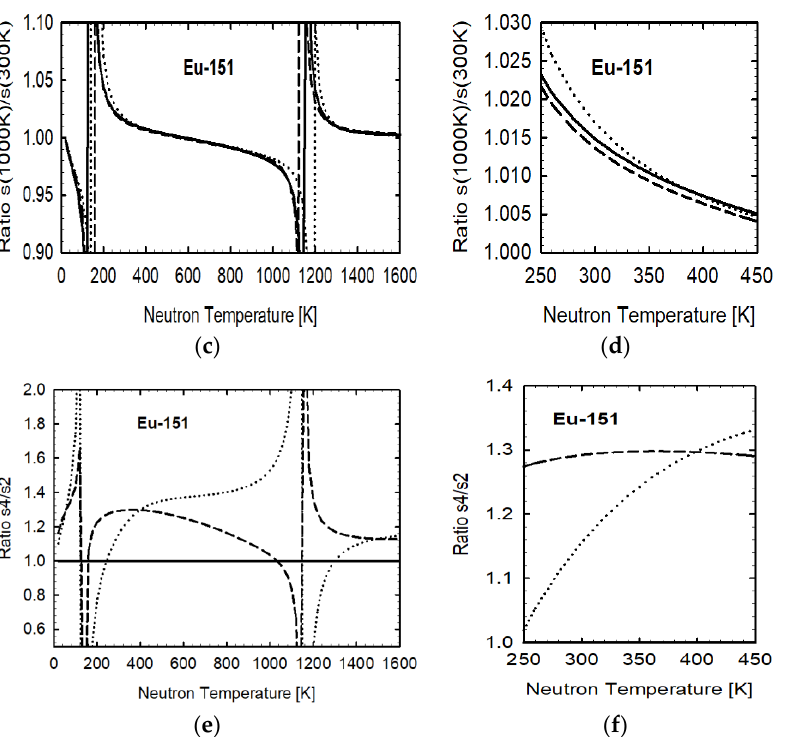
Figure 7. ( a ) s-factors, s 2𝑊 (solid line), s 4𝑊 (dotted line), s 4𝐻 (dashed line) for 151 Eu as a function of neutron temperature 𝑇 𝑛 , for sample temperatures 𝑇 𝑠 = 300 K (black) and 1000 K (red); ( b ) Expanded figure of ( a ); ( c ) Ratios of s 2𝑊 (solid line), s 4𝑊 (dotted line), s 4𝐻 (dashed line) between 𝑇 𝑠 = 300 K and 1000 K; ( d ) Expanded figure of ( c ); ( e ) Ratios of s-factors, s 4𝑊 /s 2𝑊 (dotted line) and s 4𝐻 /s 2𝑊 (dashed line) for 𝑇 𝑠 = 300 K; ( f ) Expanded figure of ( e ).